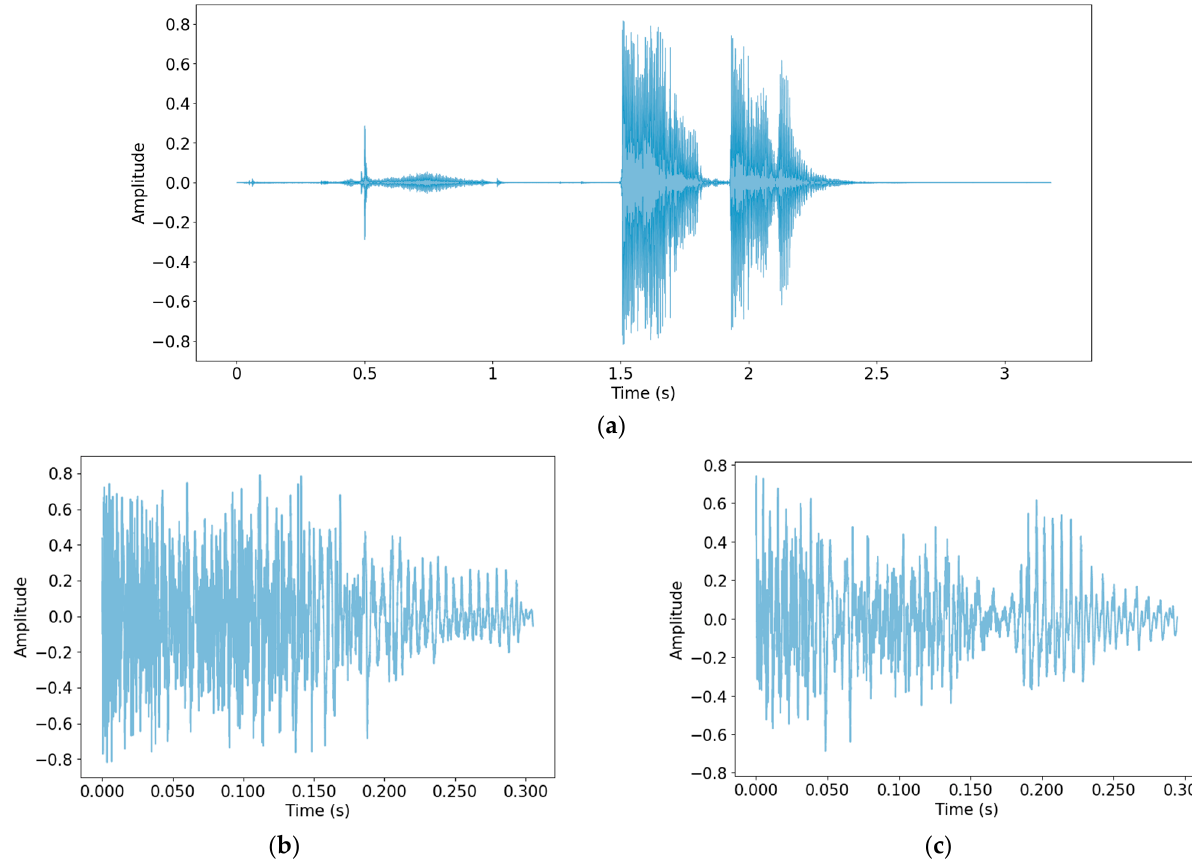
Figure 1. Performing cough detection: ( a ) Original audio file data; ( b ) detected cough segment 1; ( c ) detected cough segment 2.